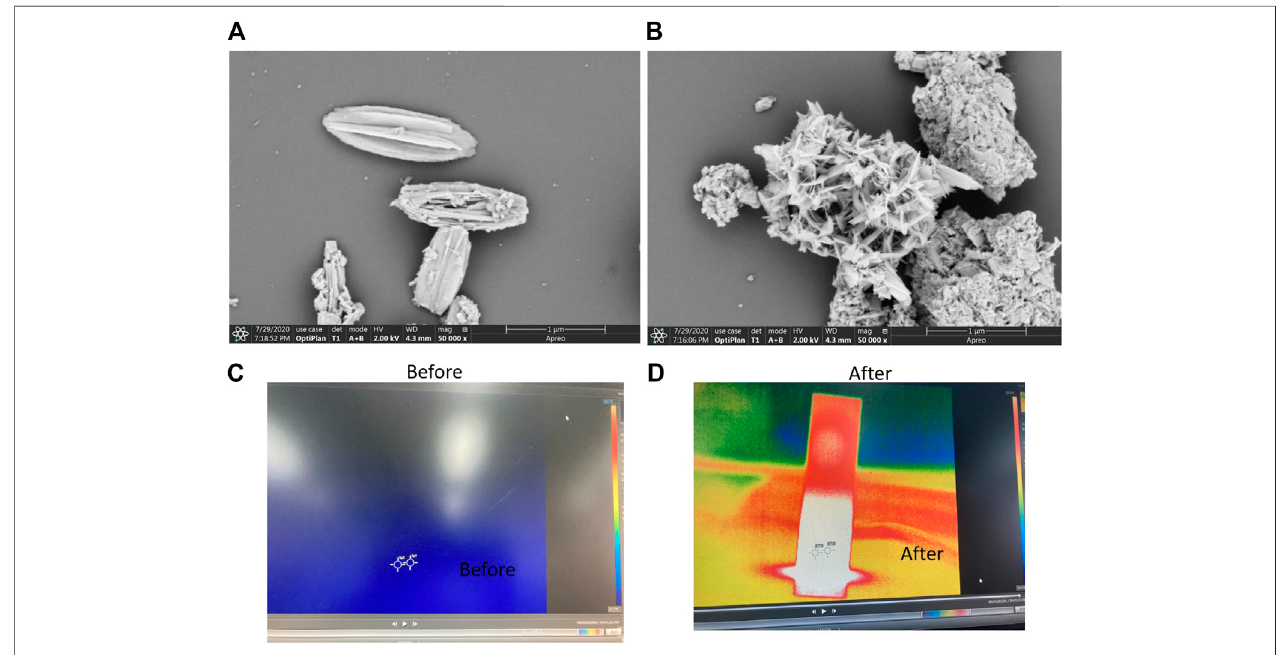
FIGURE 3 | (A) Temperature elevation curves of aqueous dispersions containing the Bi 2 S 3 NPs with different concentrations under laser irradiation. (B) Plot of temperature change ( Δ T) vs. concentration of the Bi 2 S 3 NPs. (C) Aqueous solution temperature change curve of the Bi 2 S 3 NPs at 50 μ g/ml under 808 nm NIR(1 W cm − 2 , 5 min) and the temperature decreasing process. (D) Aqueous solution temperature change curve of the Bi 2 S 3 NPs under laser on/off cycles in